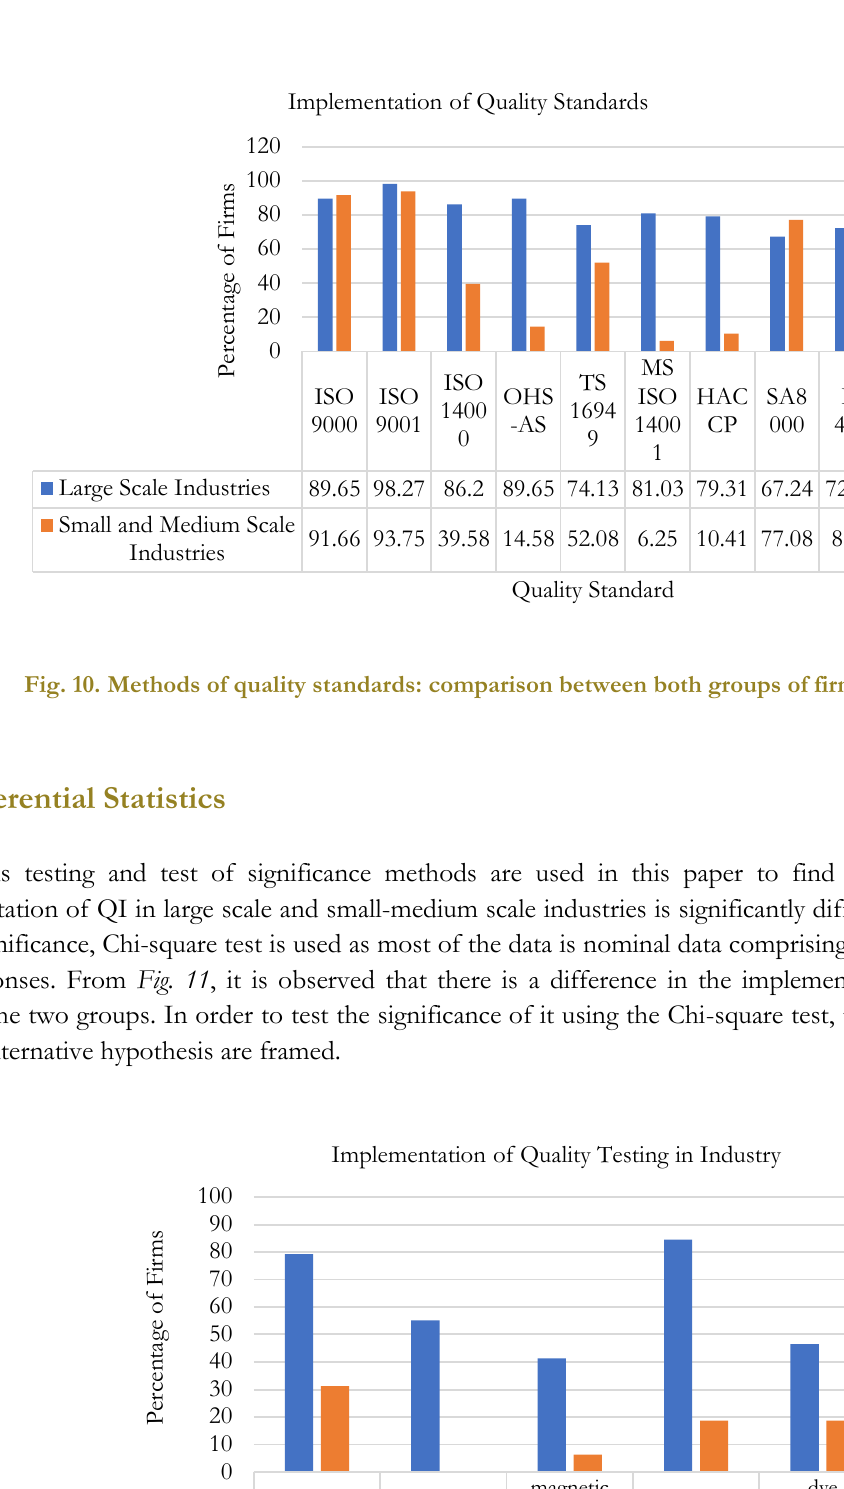
Fig. 11. Comparison of methods of testing for quality between the two